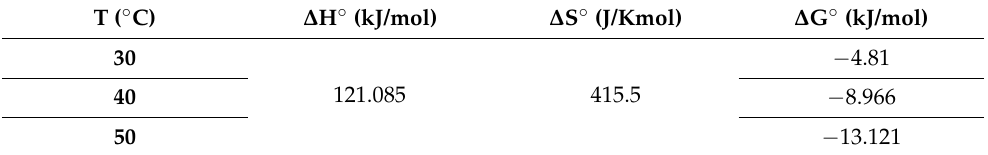
Figure 8. Van ’t Hoff plot for the adsorption of MG from aqueous solution using AP. Table 4. Thermodynamic parameters calculated for the MG adsorption from aqueous solution on